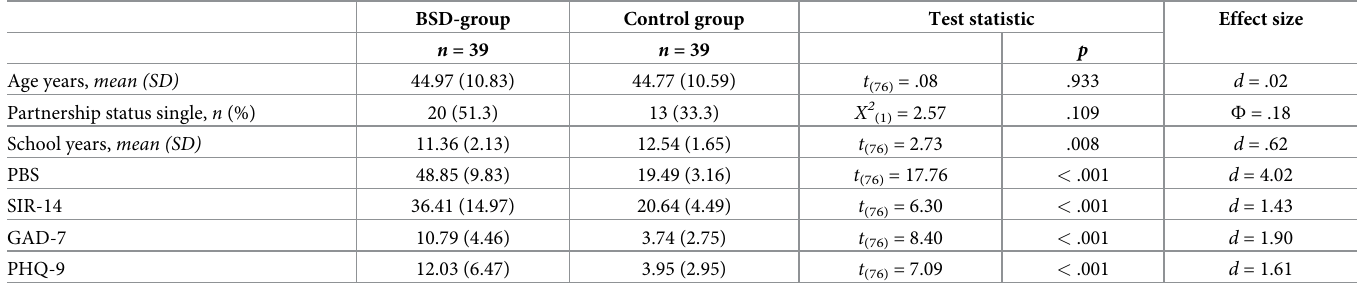
Table 1. Demographics and psychopathology.